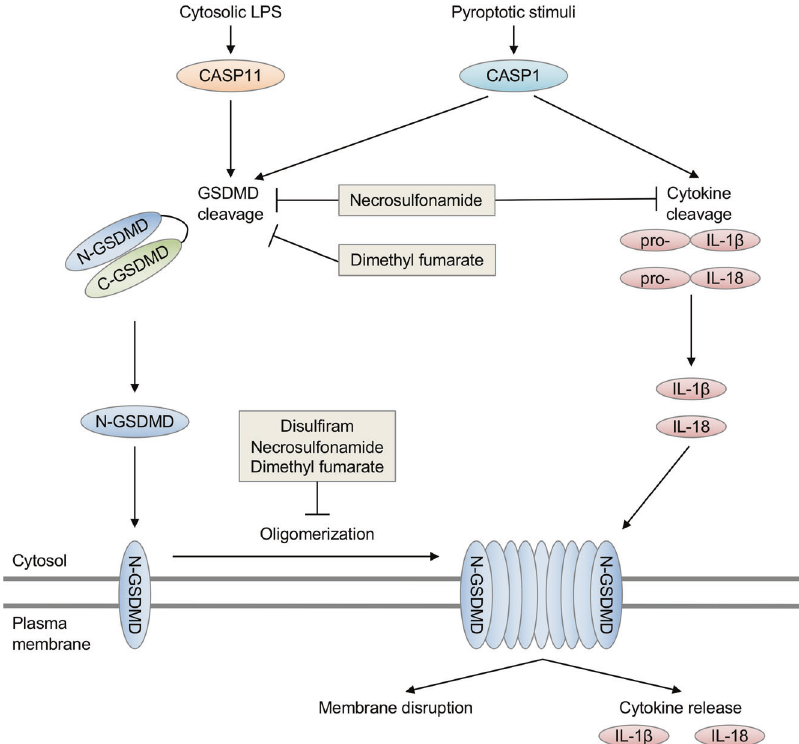
Fig. 1 Inhibition of gasdermin D-mediated pyroptosis by necrosulfonamide, disul fi ram, and dimethyl fumarate. Pyroptosis is a lytic cell death pathway activated downstream of caspase-1 and caspase-11. Activation of caspase-1/11 results in catalytic cleavage of the substrate gasdermin D (GSDMD), which releases the autoinhibitory C-terminal domain (C-GSDMD) from the pore-forming N-terminal domain (N-GSDMD). Cleavage results in N-GSDMD insertion into the plasma membrane and N-GSDMD oligomerization, forming a pore and leading to membrane disruption. Caspase-1 cleavage of IL-1 β and IL-18 is also required for cytokine activation, while pore formation by GSDMD facilitates cytokine release from the cytosol. Inhibitors of GSDMD activity include necrosulfonamide (via alkylation), disul fi ram (via the addition of dithiodiethylcarbamoyl [DTC]), and dimethyl fumarate (via succination), which have each been shown to covalently modify the Cys191 residue of murine GSDMD, blocking its activity. In addition to directly targeting GSDMD, off-target effects of these compounds on caspase-1 cleavage and activation have been